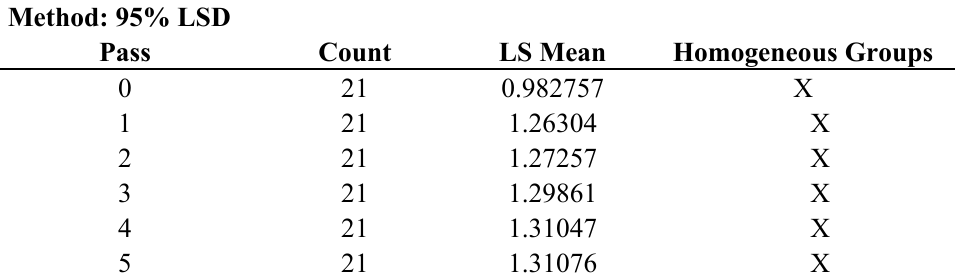
Table 4. Multiple Range Test for cone index vs.